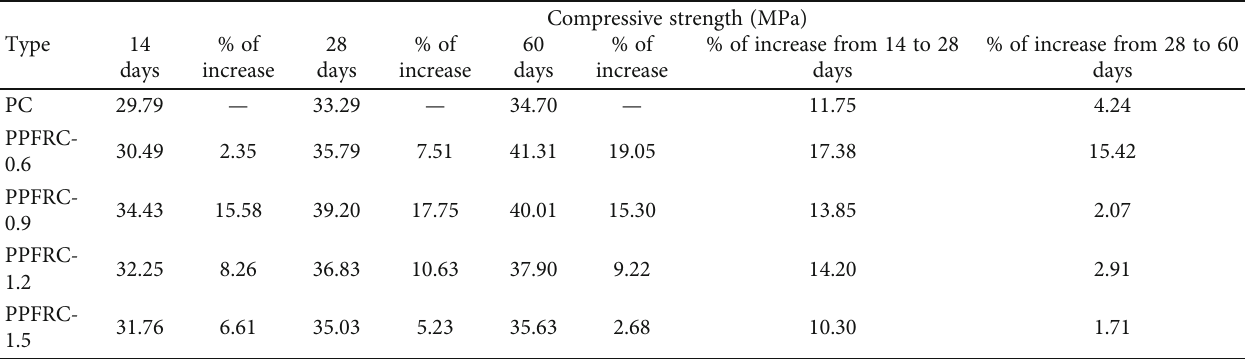
Figure 11: Slopes of the trend line of descent stage of load – time curves at 14, 28, and 60 days of Table 5: The compressive strength of PC and PPFRC at 14, 28, and 60 days of curing.